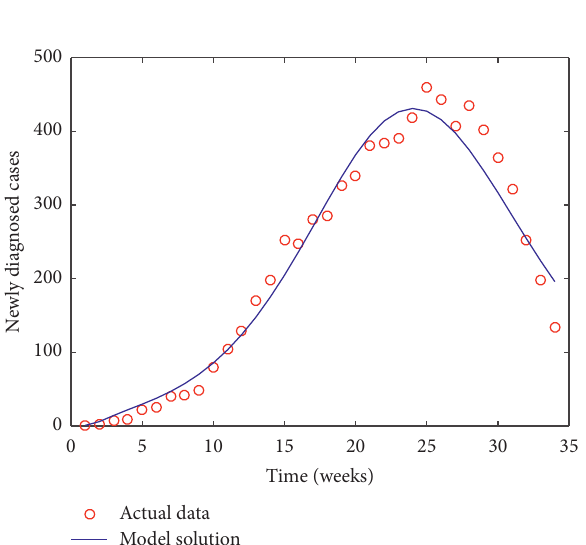
Figure 5: Evolutionary process of model optimal solution. Here, the yellow solid line represents the evolutionary process of the fitness values corresponding to the optimal parameters of each generation, while the blue solid line represents the early amplifi- cation part of the model